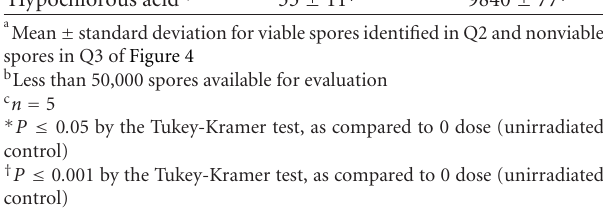
Table 2: Fluorescence intensity of EB-irradiated Bacillus spores after SYTO-9 and propidium iodide (PI) uptake. a